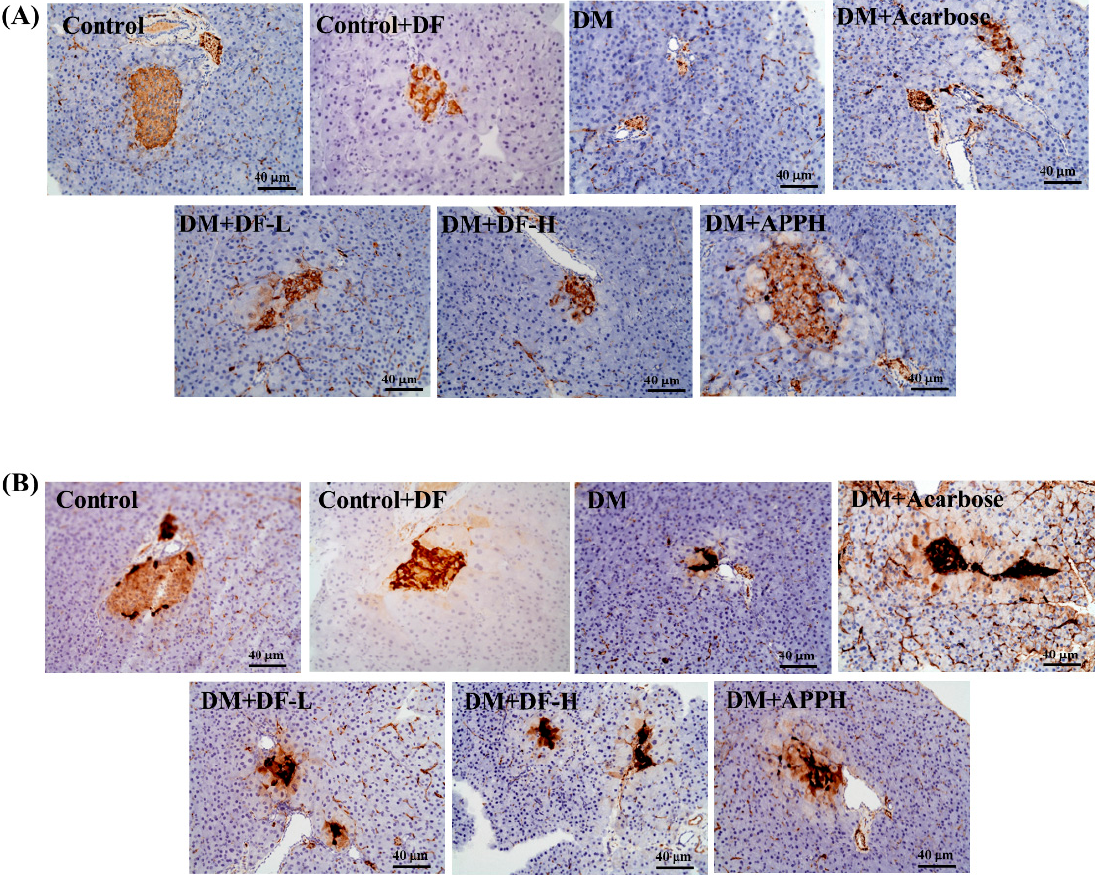
Figure 5. Changes in the DM-induced modulations in glucagon and insulin secretion. Immunohistochemical staining for insulin ( A ) and glucagon ( B ) in control mice (Control), non-diabetic mice treated with DF (Control+DF), STZ-induced diabetes mellitus mice (DM), DM mice treated with acarbose (DM+Acarbose), DM mice treated with low-dose DF peptide (DM+DF-L), DM mice treated with high-dose DF peptide (DM+DF-H), and DM mice treated with APPH peptide (DM+APPH).